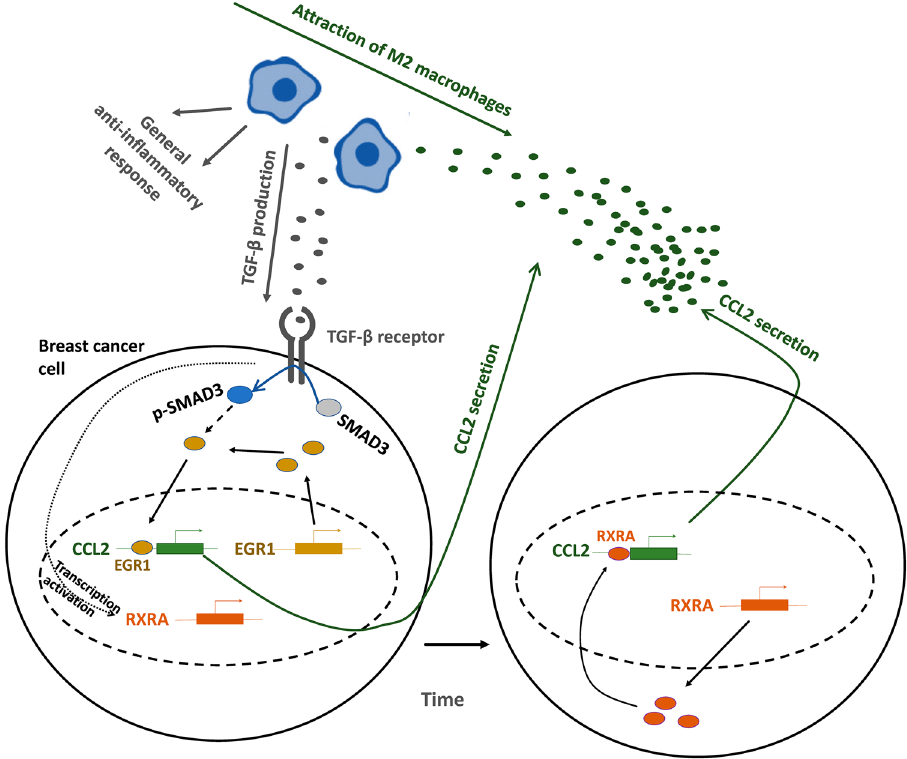
Figure 7. Schematic illustration of potential EGR1 and RXRA participation in TGF-β-CCL2 positive regulatory